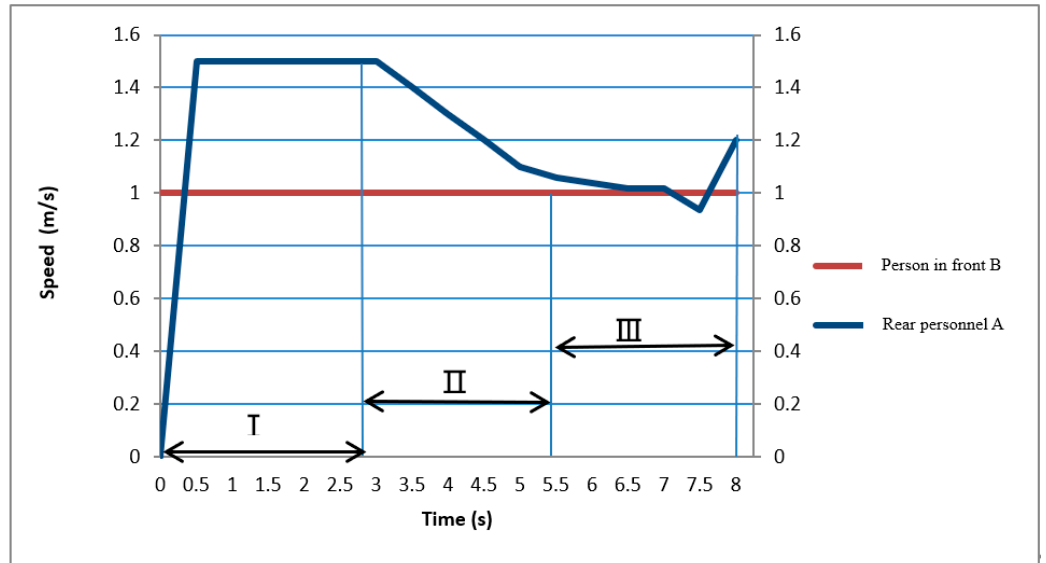
Figure 15. Speed change process of agent A.